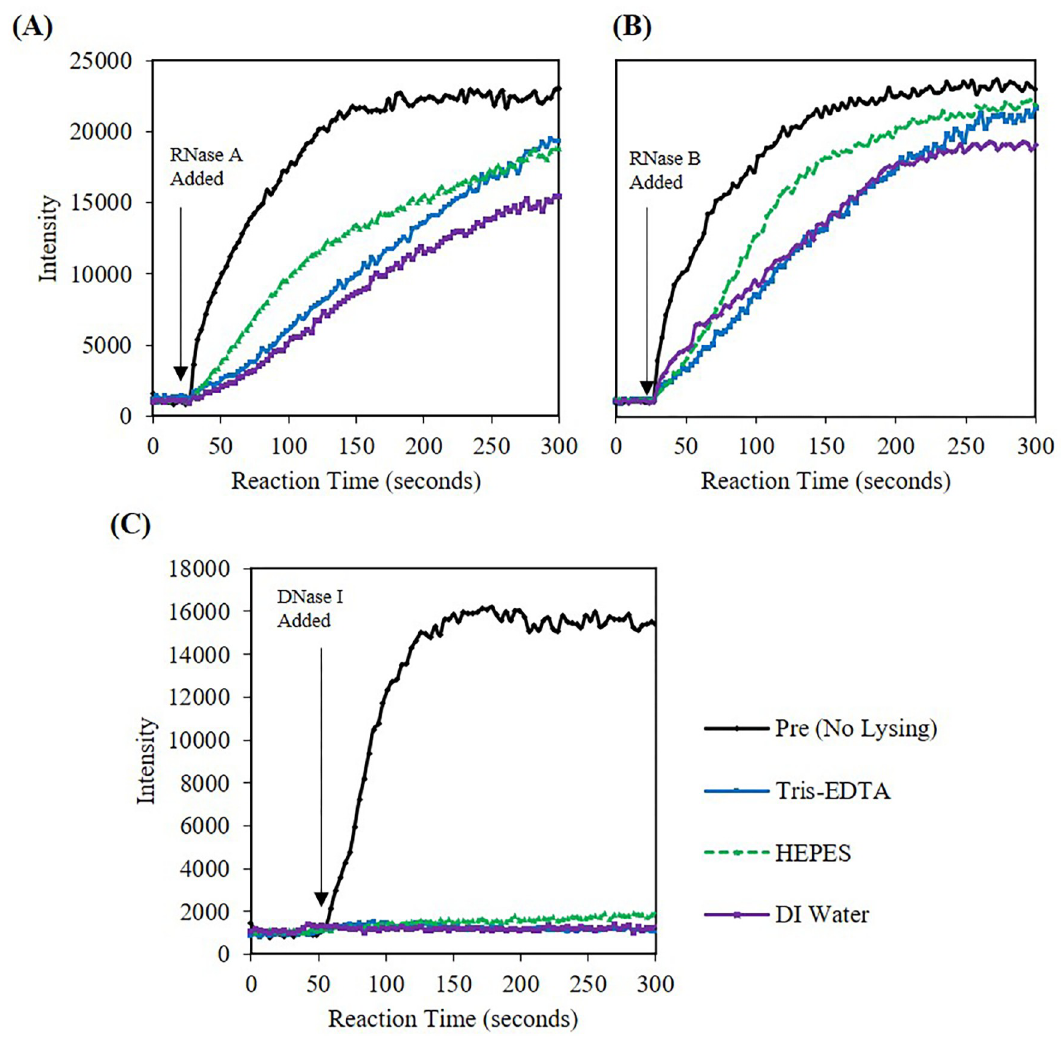
Fig 8. Fluorescent intensity at 520 nm (RNase A/B) and 556 nm (DNase I) versus time for nucleases in 1 mM buffers lysed with Lyse-It at 50% power for 60 seconds (A) 20 pM RNase A (B) 46 pM RNase B, (C) 10.5 nM DNase I. In general, HEPES buffer was seen to protect the nuclease from becoming more inactive as compared to Tris-EDTA or DI